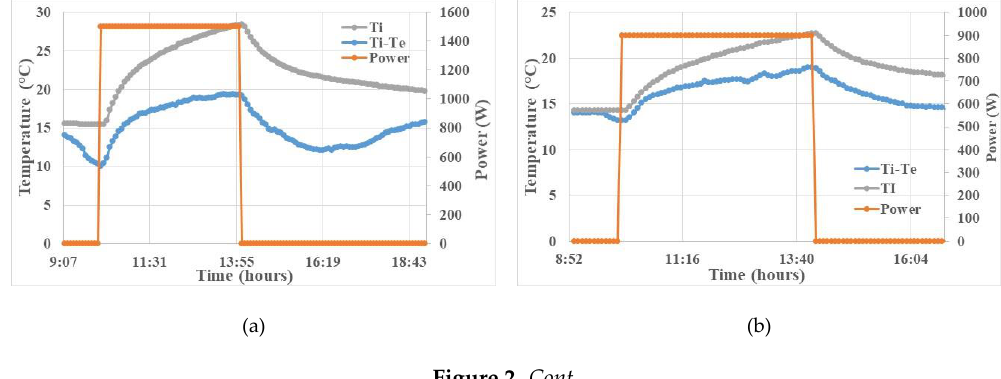
Table 2. Conducted